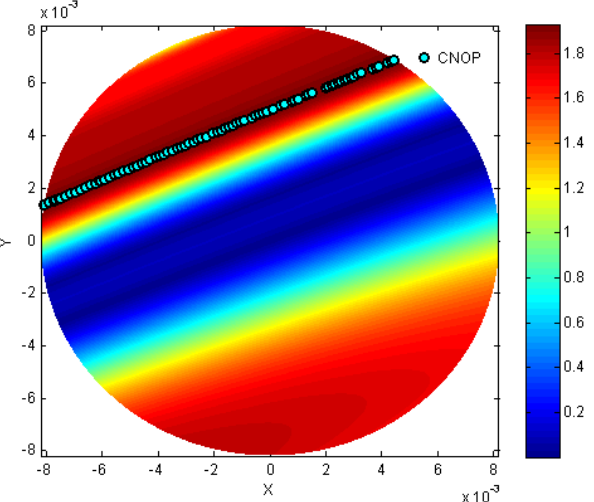
Figure 6. The distributions of OFVs at the prediction time 14 (cid:49)t , where dots are the CNOPs produced by the filtering